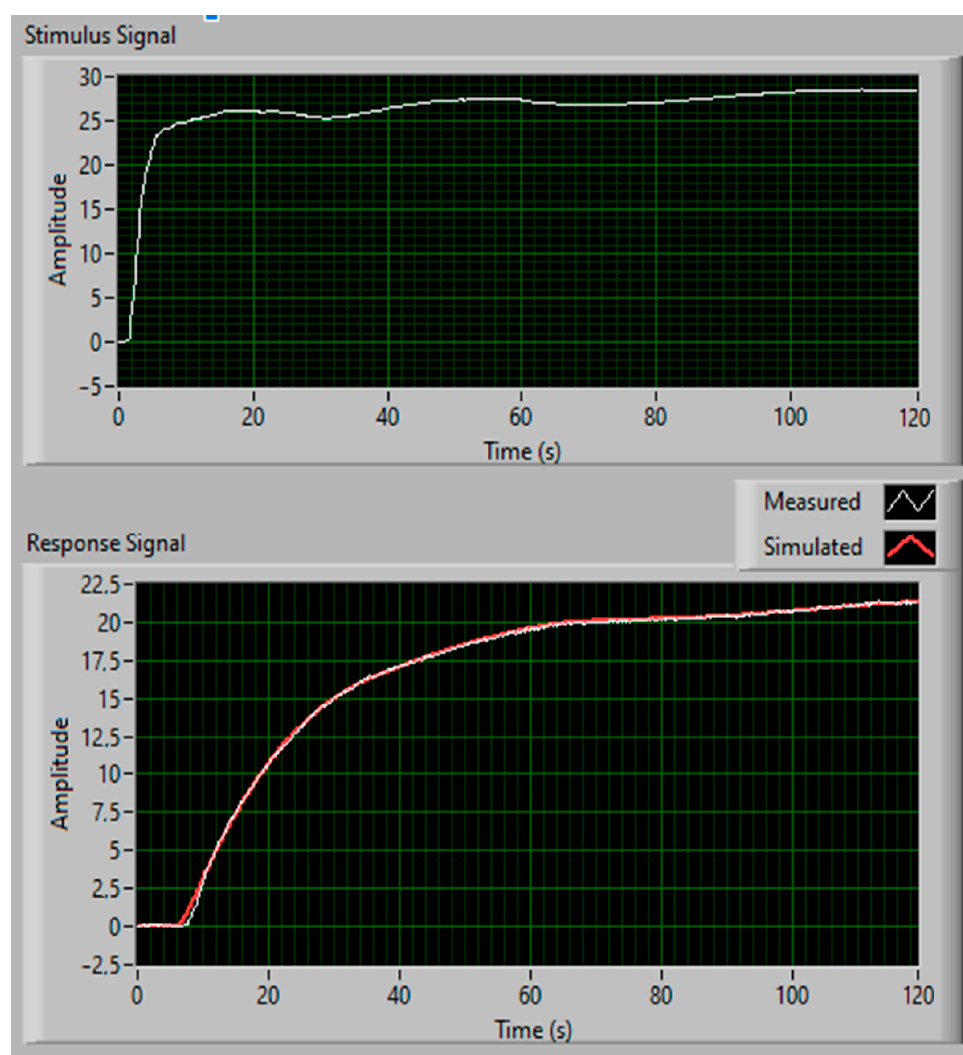
Figure 10. Thermal forcing, and real and approximated responses. The real response and its approximation were almost the same. The root mean square error (RMSE) equaled 0.1269, when forced by a jump with a temperature of 28 °C. In further analyses, the gain, k , and delay, To , related to liquid transport in the test facility, were omitted; however, they could help correct the results. The focus was on time constant, T , depending on the object wall thickness and the distance from the point where TC1 was installed. Example results of the time constant T values, determined during the modelling of M1, are shown in Figure 11 (blue and red points).